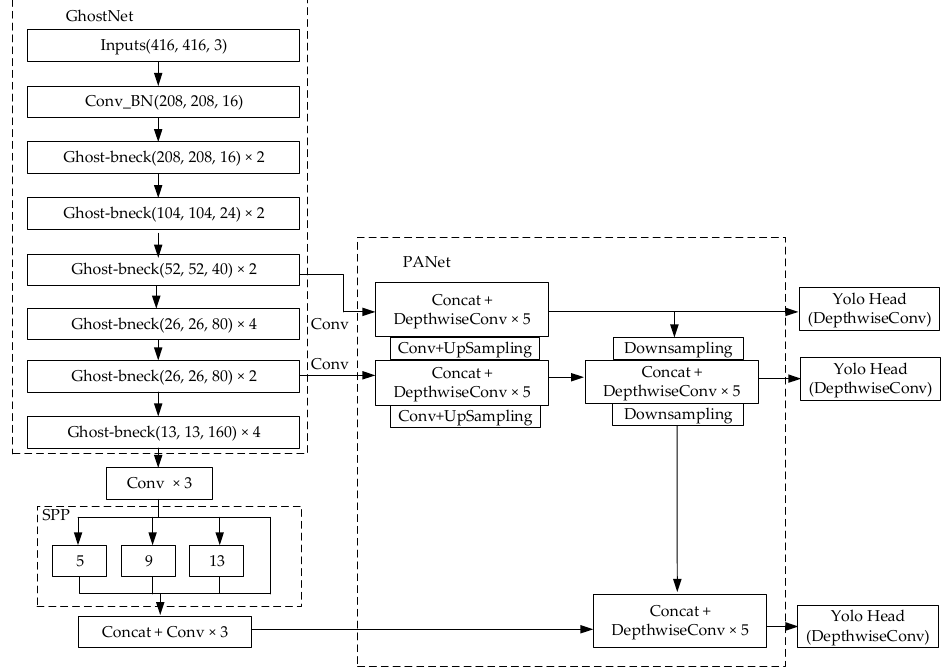
Figure 6. Ghost–YOLOv4 network